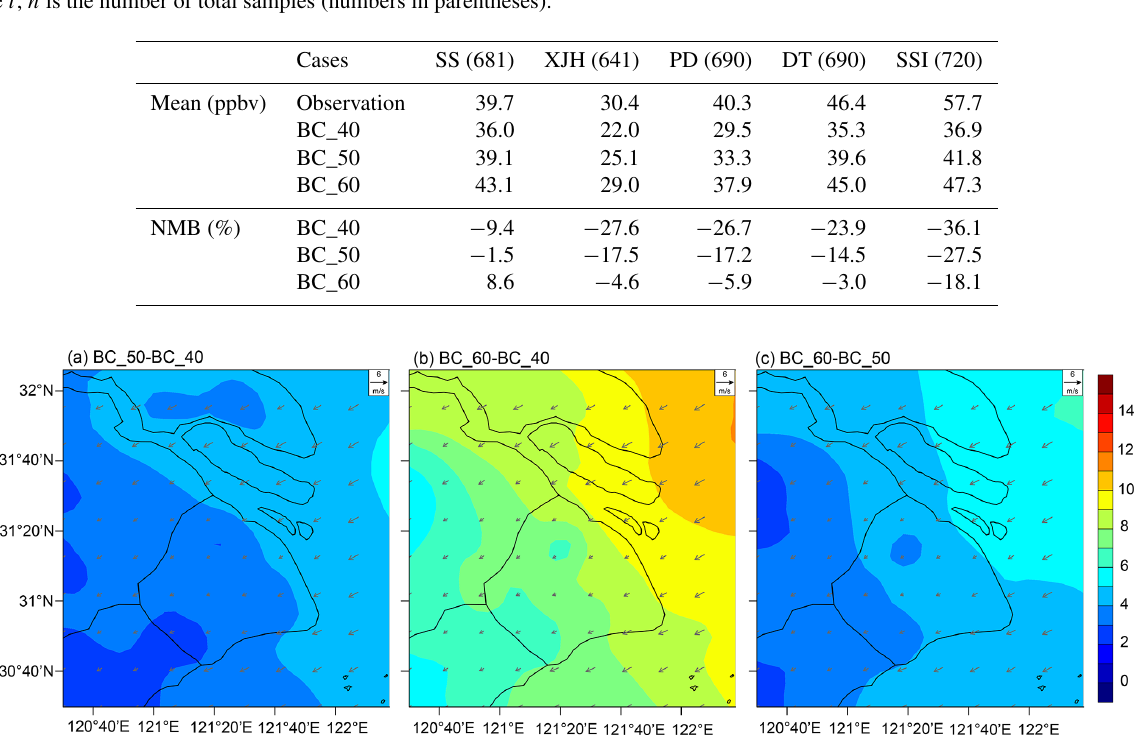
Figure 9. Mean differences in surface O 3 concentrations (ppbv) simulated with different chemical boundaries: (a) BC_50 minus BC_40, (b) BC_60 minus BC_40 and (c) BC_60 minus BC_50 in September 2014. Also shown is the calculated wind field (ms − 1 ) averaged over the simulation